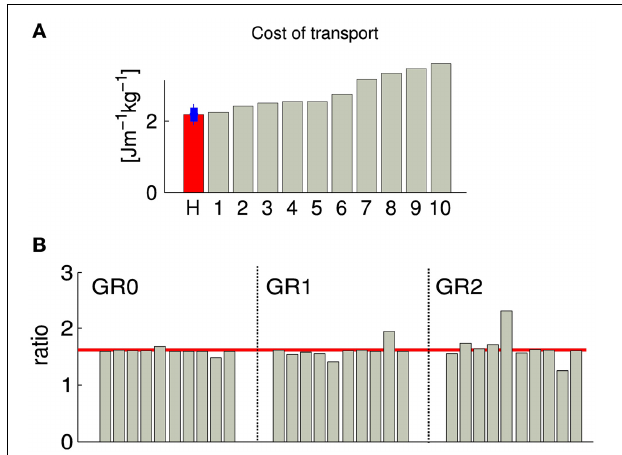
FIGURE 4 | Each gray bar corresponds to one solution of the same optimization process (optimizing for a stable gait walking at 1.3m/s). (A) Normalized cost of transport. The red bar corresponds to the normalized cost of transport of human subject of the similar weight and walking speed as our obtained gait (data from Weyand et al., 2010), the blue bar shows the estimated standard deviation. (B) Duration proportion of the different gait phases. GR0 corresponds to the ratio between cycle duration and stance duration, GR1 corresponds to the ratio between stance duration and swing duration and GR2 corresponds to the ratio between swing duration and double stance support. The red line corresponds to the golden ratio √ 5 φ = 1 + 2 . GR0, GR1, and GR2 are known to be statistically similar to the golden ratio in human walking at their preferred speed (Iosa et al.,